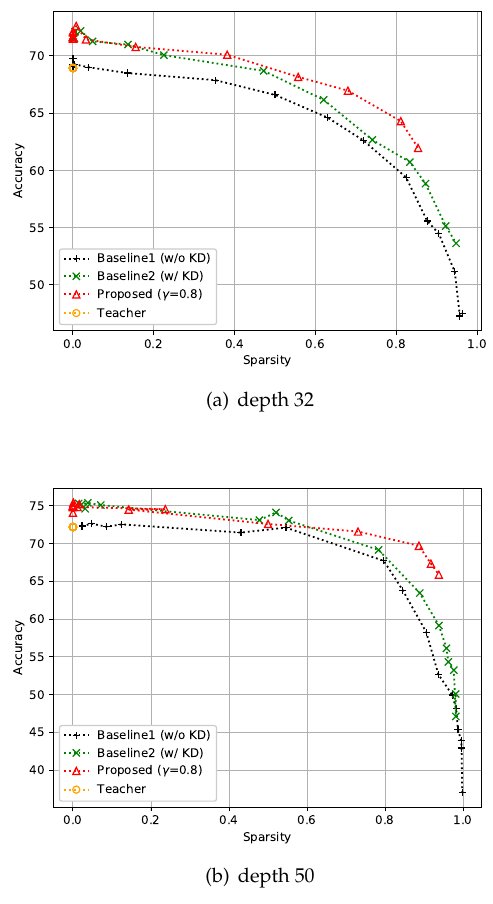
Figure 6. Effect of the proposed strategies on CIFAR-100. Here, the hyper-parameter γ is the relaxation variable shown in Equation